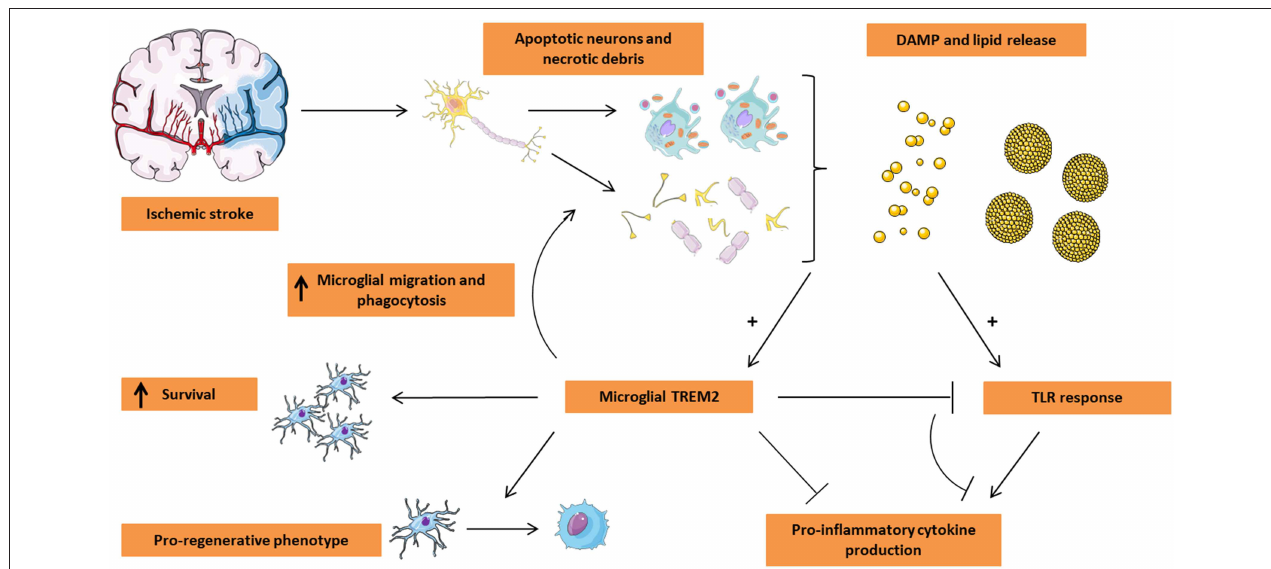
FIGURE 1 | Microglial TREM2 in stroke pathogenesis. Ischemic stroke leads to the massive loss of neuronal tissue by triggering apoptosis and/or necrosis. In turn, the dying tissue releases damage-associated molecular pattern (DAMP) molecules including nucleotides and ECM breakdown products in addition to lipid mediators being present in myelin and neuronal debris and on the surface of apoptotic cells. These events trigger both TLR and TREM2 activation on microglia. While classically the TLR response leads to a pro-inflammatory microglial phenotype characterized by the release of pro-inflammatory cytokines, TREM2 activation appears to counteract the TLR response, leading to a decrease in the production of pro-inflammatory cytokines. Moreover, microglial TREM2 stimulates migration of microglia toward the lesion site and promotes the phagocytic clearance of apoptotic cells and debris. Finally, TREM2 was shown to be associated with a pro-regenerative microglial phenotype and the production of pro-regenerative cytokines and is suspected to play a role in microglial survival. Based on these functions of TREM2, this receptor is an attractive target for microglial modulation in the treatment of ischemic stroke. This Figure was created using Servier Medical Art licensed under